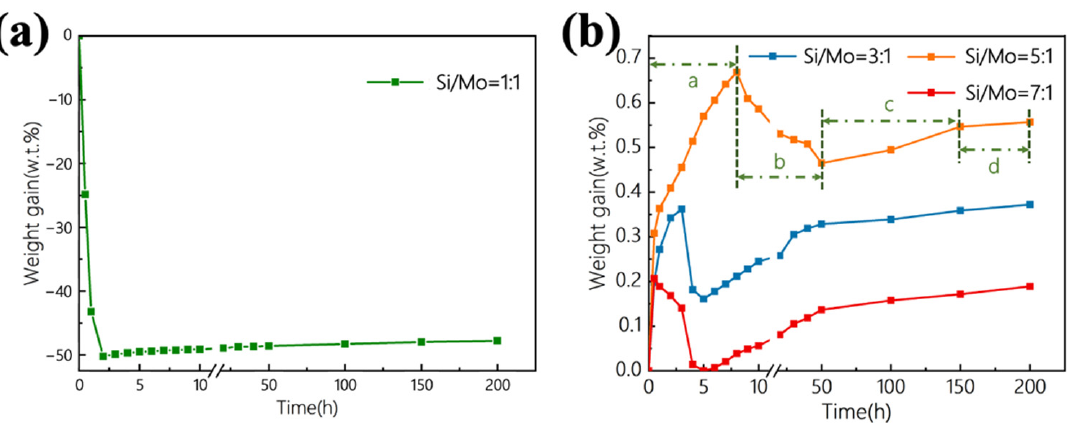
Figure 4. Isothermal oxidation curves of the coated samples with different Si/Mo ratio: ( a ) 1:1; ( b ) 3:1, 5:1, 7:1.